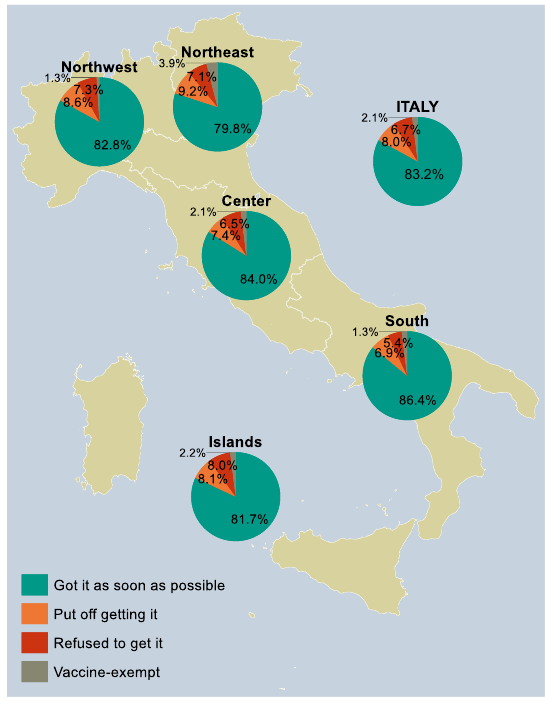
Figure 1. COVID-19 vaccine uptake in the study sample between January 2021 and April/May 2022 ( n = 10,000), overall and by NUTS statistical region. Percentages were post-stratified by using the distribution of Italy’s resident adult population by NUTSregion, gender, and age group as of Janu- ary 1, 2022. Notes: Northwestern Italy includes Piedmont, Aosta Valley, Lombardy, and Liguria; Northeastern Italy includes Trentino-South Tyrol, Veneto, Friuli-Venezia Giulia, and Emilia-Roma- gna; Central Italy includes Tuscany, Umbria, Marche, and Lazio; Southern Italy includes Abruzzo, Molise, Campania, Apulia, Basilicata, and Calabria; Insular Italy includes Sicily and Sardinia. Ab- breviations: COVID-19, coronavirus disease 2019; NUTS, Nomenclature of Territorial Units for Sta- tistics.